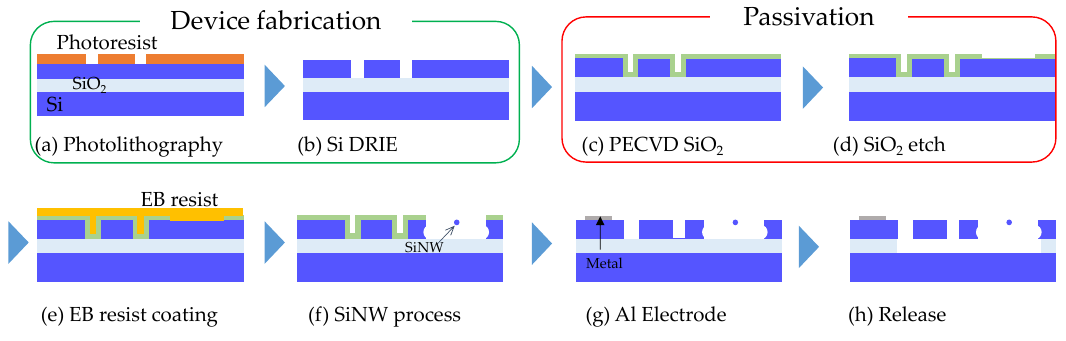
Figure 2. Fabrication process flow. EB—electron beam; SiNW—silicon nanowire; PECVD—plasma enhanced chemical vapor deposition; DRIE—deep reactive ion etching.